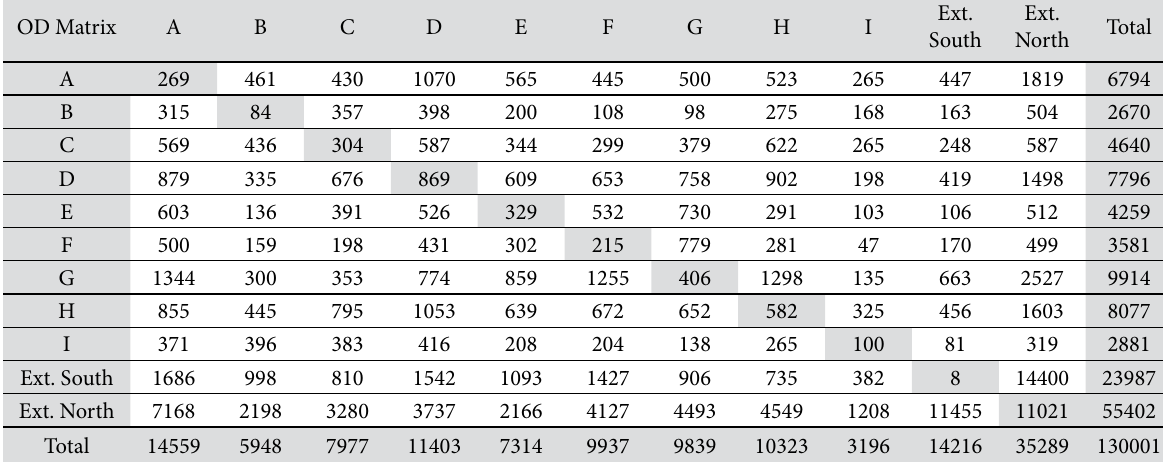
Table 2. Origin/Destiny Matrix for each sector (number of displacements in individual transport) for the morning traffic peak period (7:30÷9:30 h) (Oliveira et al. 2007)